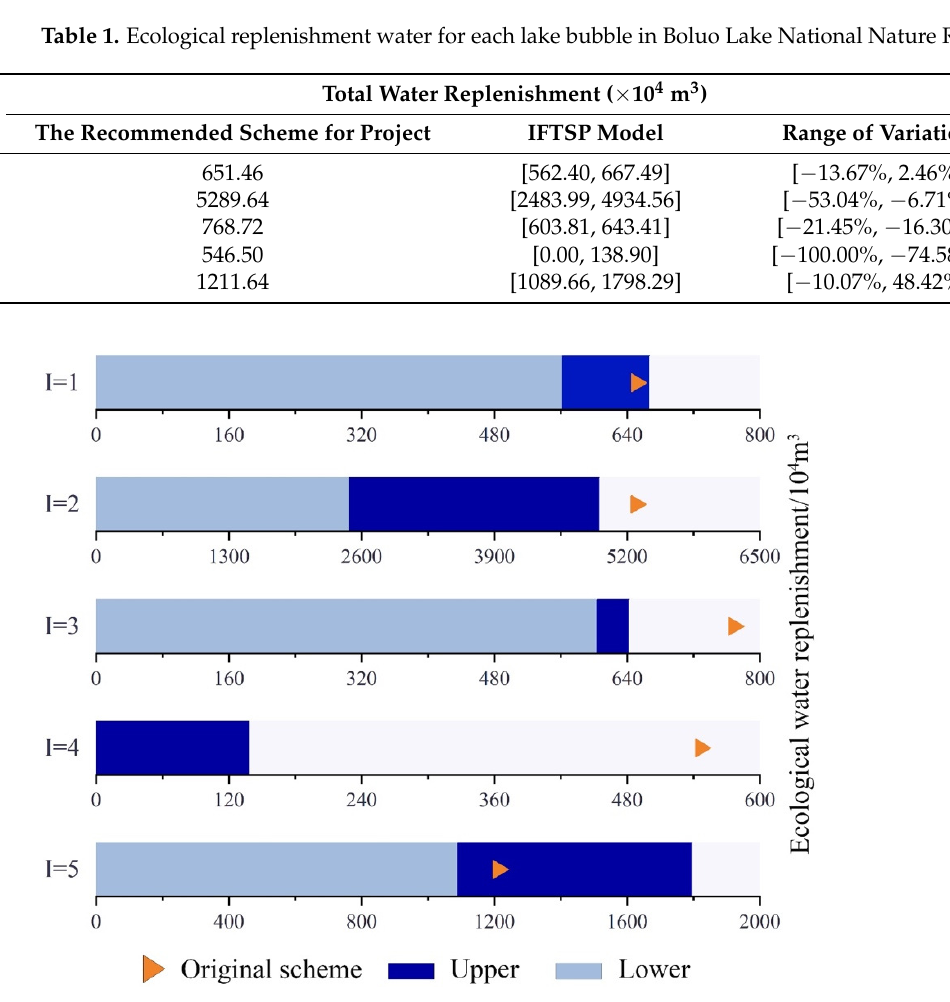
Figure 2. Comparison between recommended project scheme and the IFTSP-based model optimi- sation scheme for ecological water replenishment of each lake in the Boluo Lake Wetland National Nature Reserve. (I = 1 to 5 represent the Toudaogang Reservoir, Boluo Lake, Mobopao, Yuanbaowapao, and Aobaotupao, respectively).